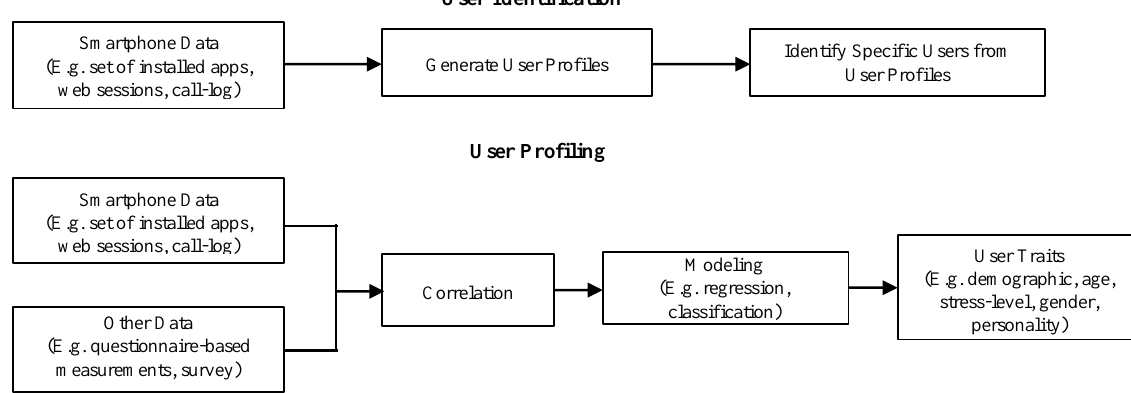
Fig. 2. User identification and user profiling general